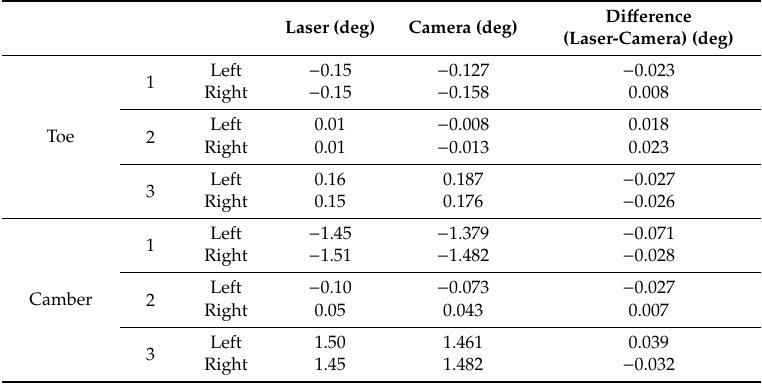
Table 3. Measurement and verification